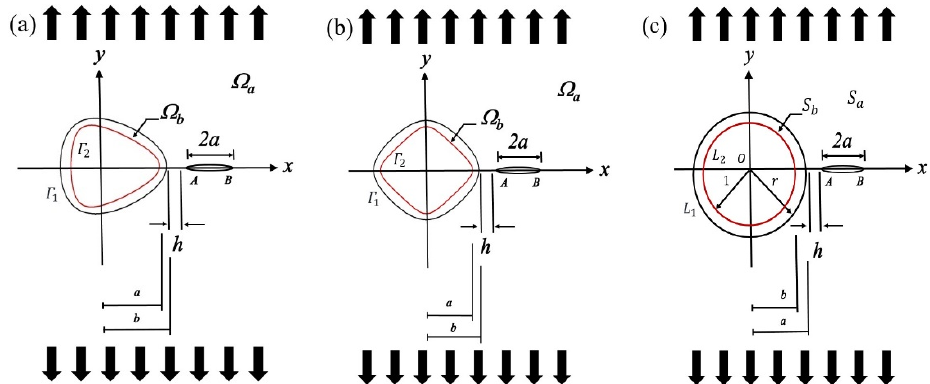
Figure 3. ( a ) Approximately triangular hole with inclusion layer on physical plane (z-plane); ( b ) approximately square hole with inclusion layer on physical plane (z-plane); ( c ) irregular hole with inclusion layer on mathematical plane ( ζ